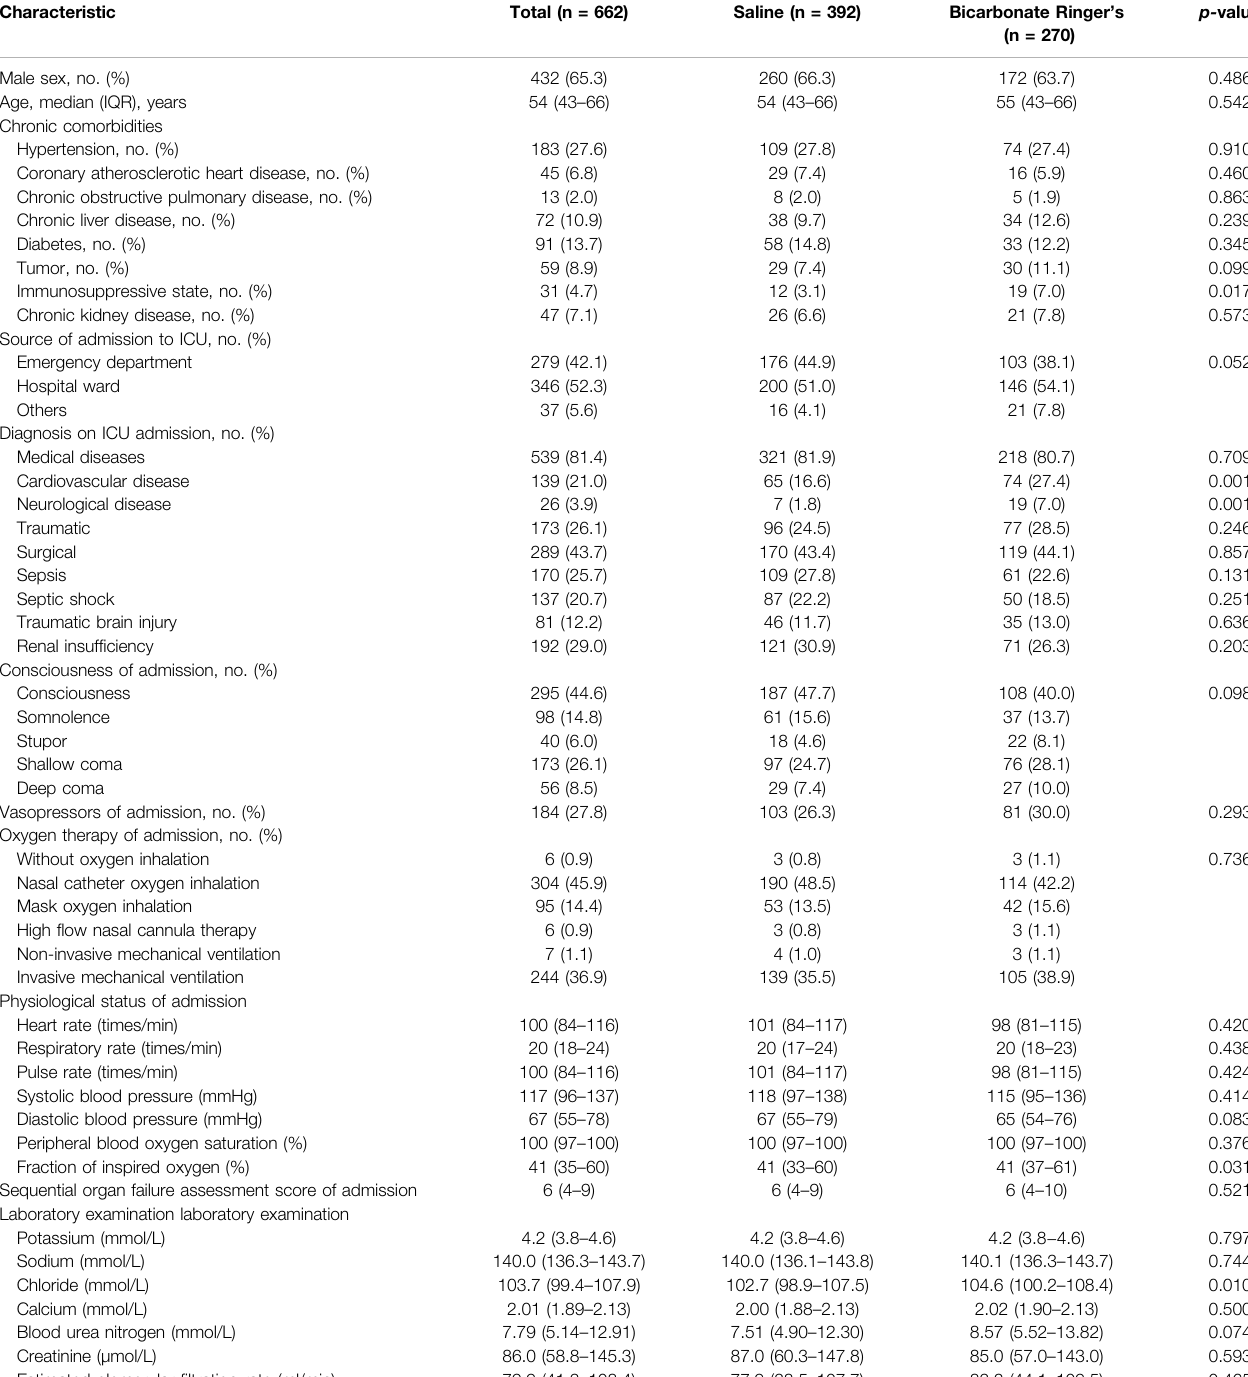
TABLE 1 | Participants ’ baseline characteristics at ICU